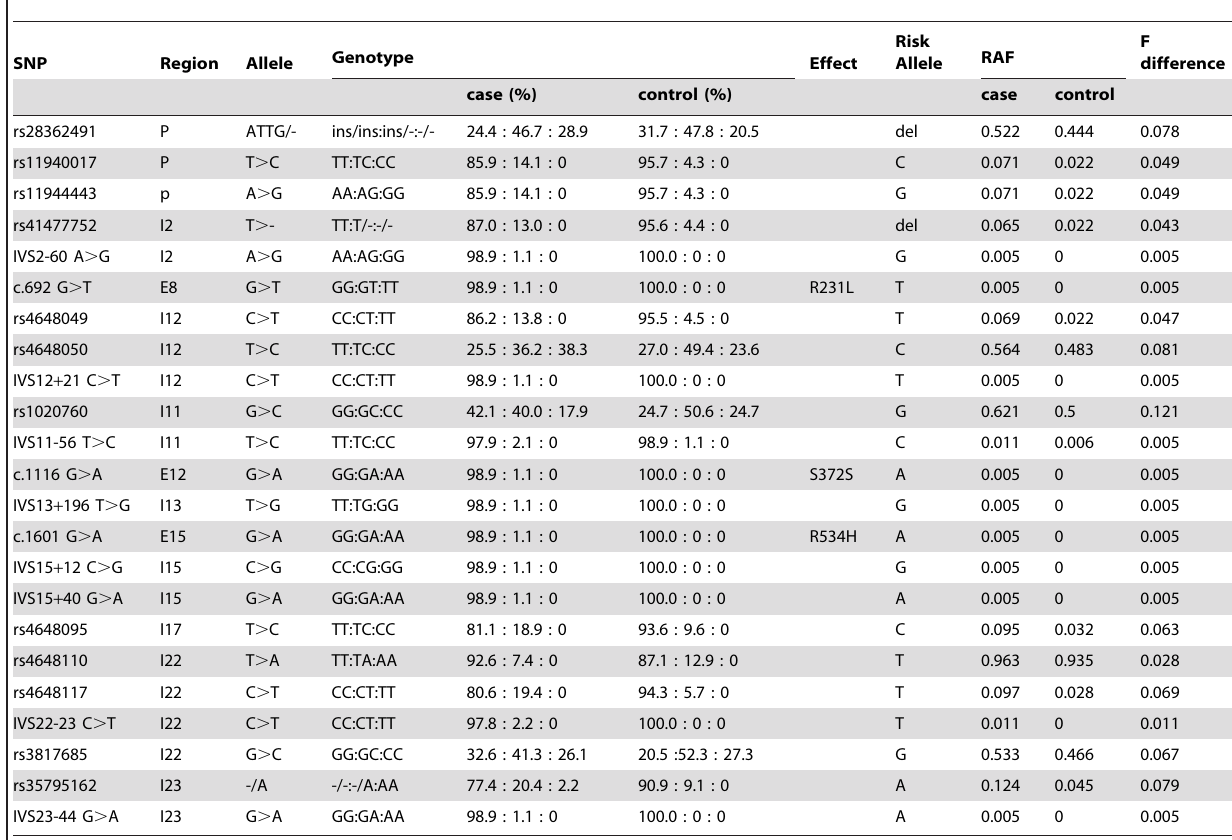
Table 3. Variants identified in NFKB1 by direct sequencing in 94 TRS cases and